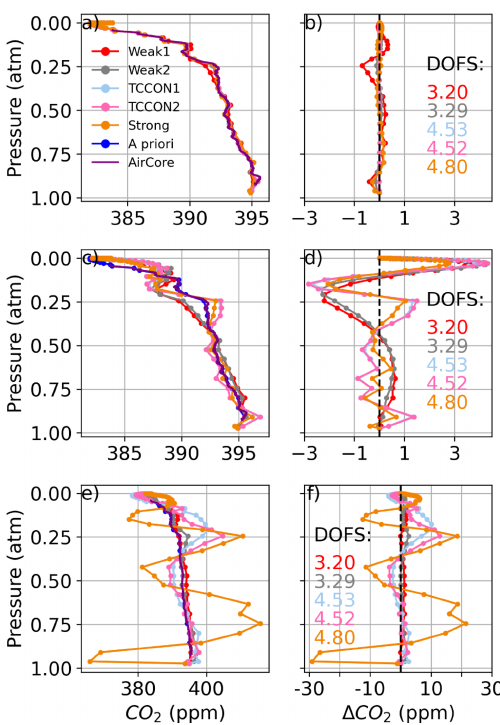
Figure F2. The left-hand panels show CO 2 profiles retrieved using synthetic spectra. In (a) , we use the AirCore profile, which was used to generate the synthetic spectra, as the a priori profile. In (c) , the internal field of view is perturbed by + 7%, increasing the width of the ILS. In (e) , the zero-level offset is perturbed by + 0.002 and is not retrieved in the Strong window. Panels (b) , (d) , and (f) show the difference between the retrieved profiles and AirCore, correspond- ing to (a) , (c) , and (e) respectively.